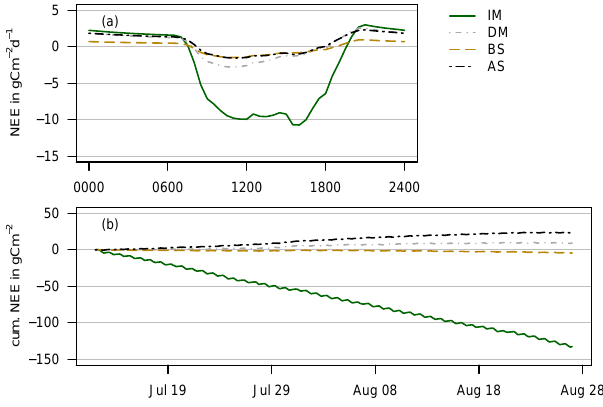
Figure 6. Model results of net ecosystem exchange (NEE) over 46 days of July and August 2012 at Kema. (a) : mean diurnal cycle, and (b) : cumulative NEE. The four lines represent different stages of vegetation degradation (IM, DM, BS, and